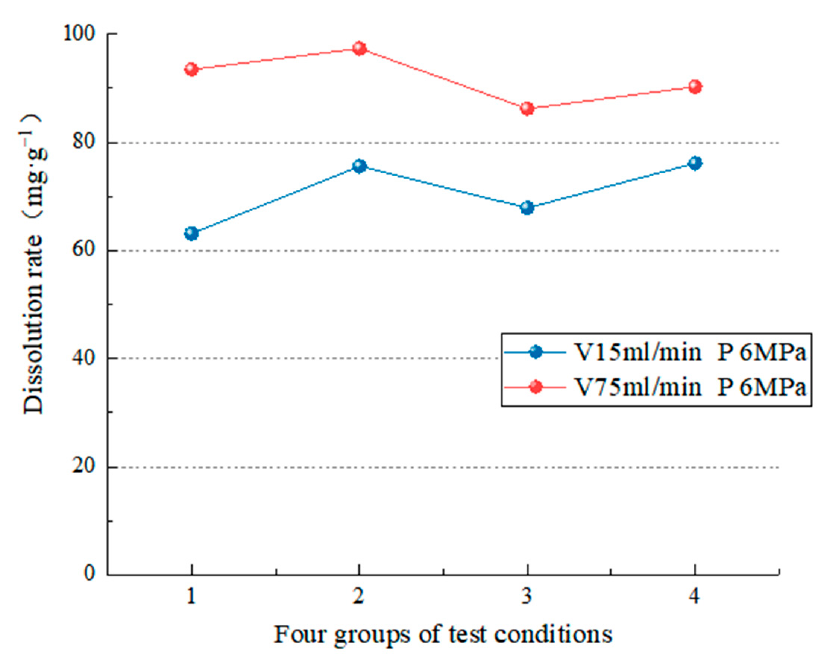
Figure 12. Comparison of the dissolution rate at a pressure of 6MPa.